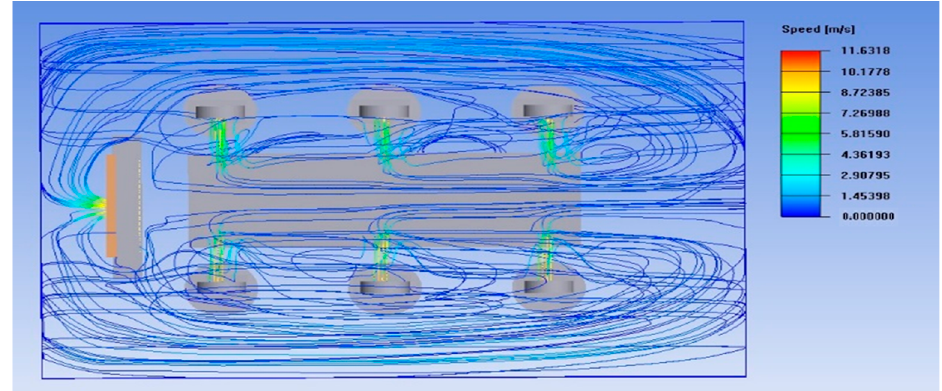
Figure 28. Air purifier simulation top view in the conference room at a low rotation speed -2.